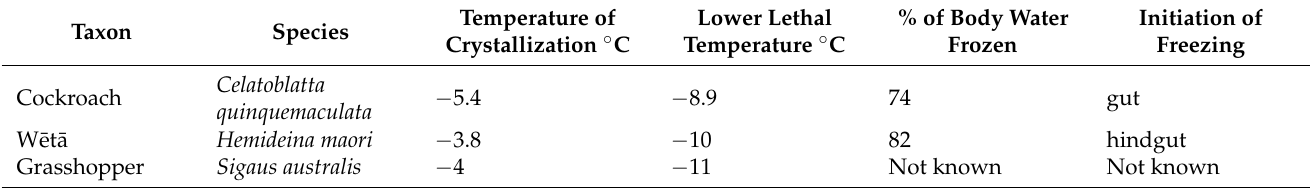
Table 1. Comparison of critical temperatures for three alpine insects from Aotearoa-New